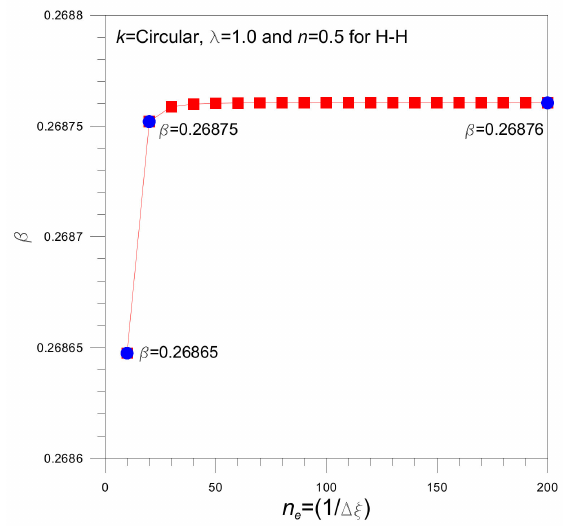
Figure 2. Convergence analysis for a suitable n e (= 1/ ∆ ξ ) in the Runge–Kutta